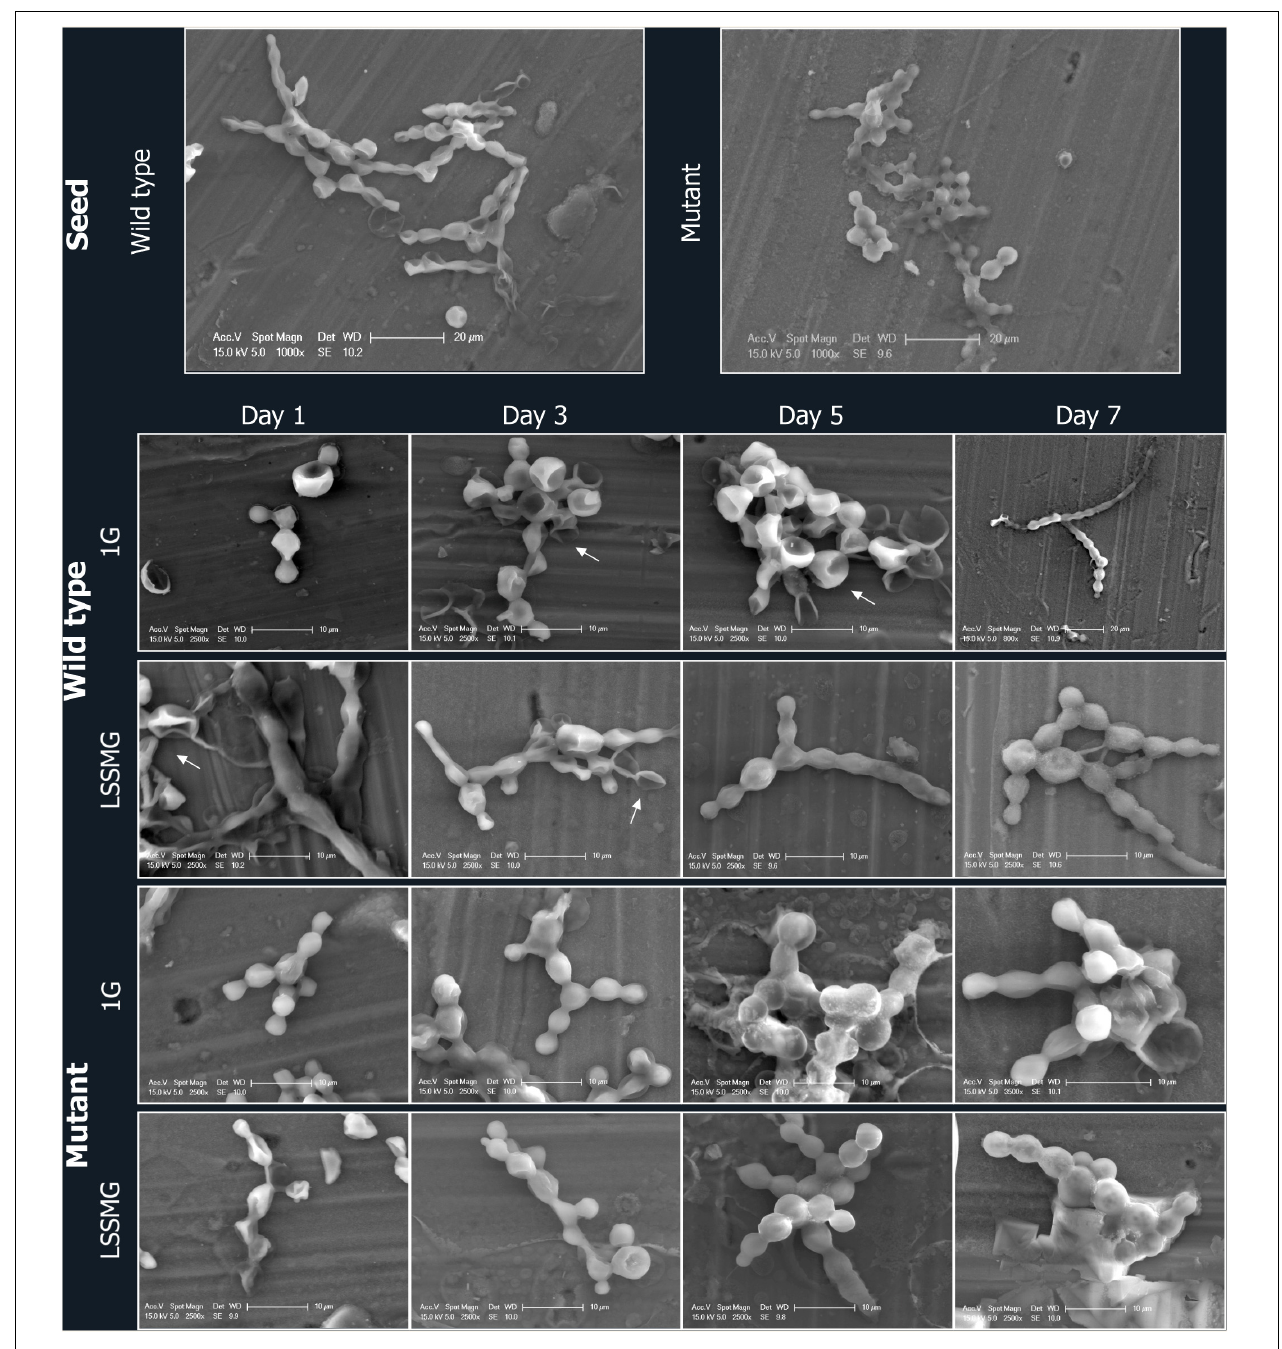
FIGURE 3 | FE-SEM micrographs of Knufia chersonesos Wt and Mut on aluminum coupons during a 7-days exposure to LSSMG or 1G (control). Details of cells morphology are shown; arrows indicate biconcave cell morphology.